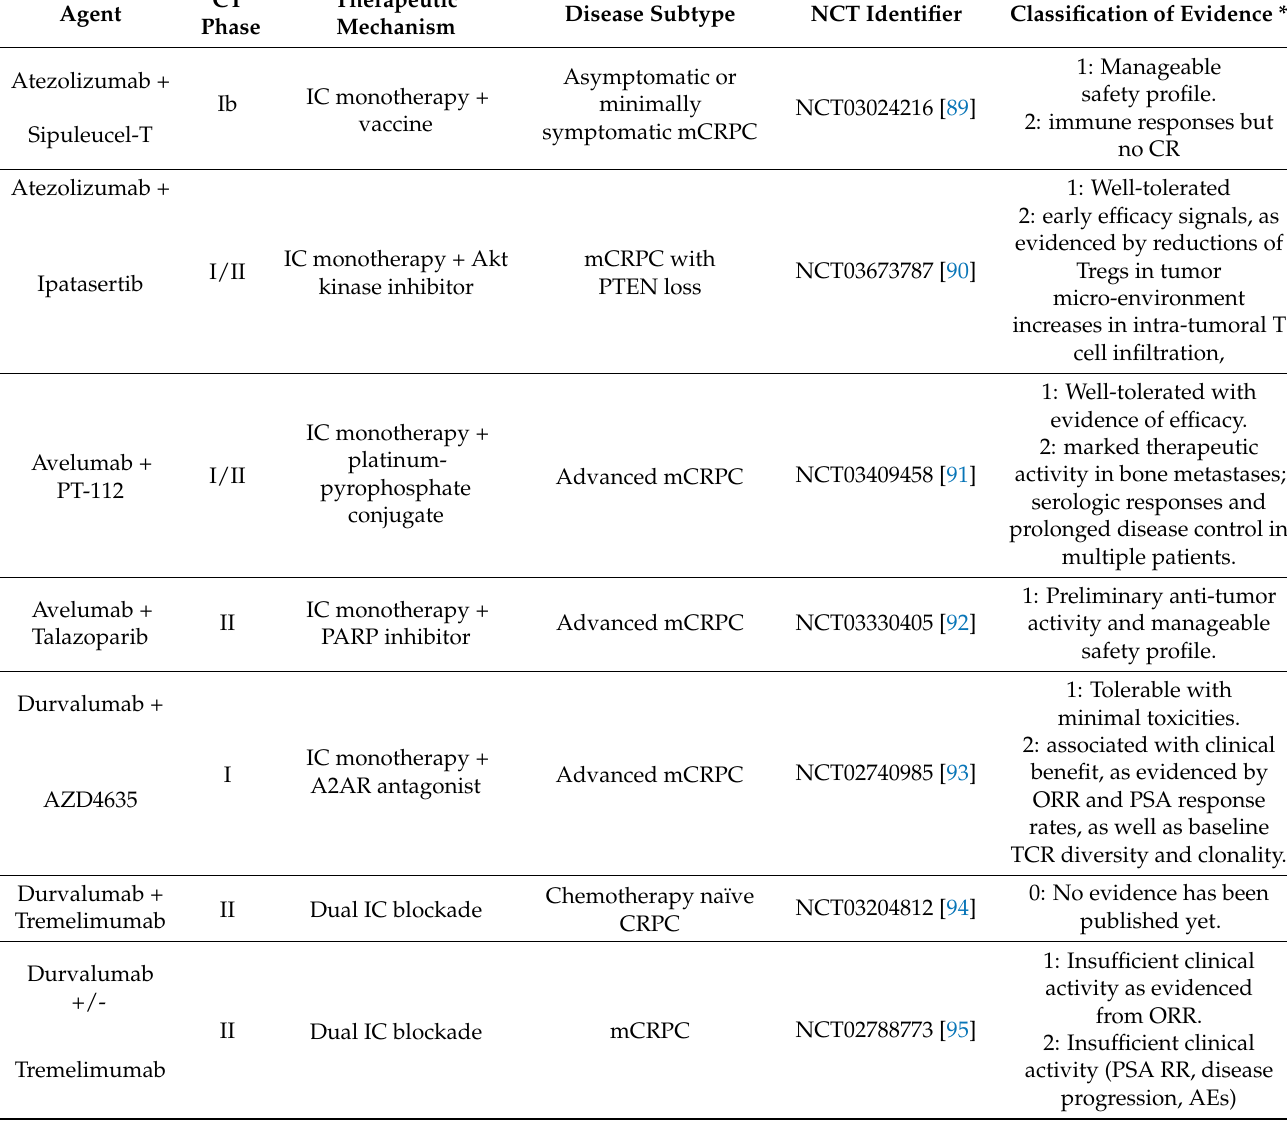
Table 1. Ongoing clinical trials evaluating immune checkpoint inhibitors (ICIs) as therapeutic regimens for PCa (adapted from Kim et al., 2020 and Rizzo et al., 2020) [59,88]. CT Therapeutic Disease Subtype NCT Identifier Classification of Evidence Agent Phase Mechanism